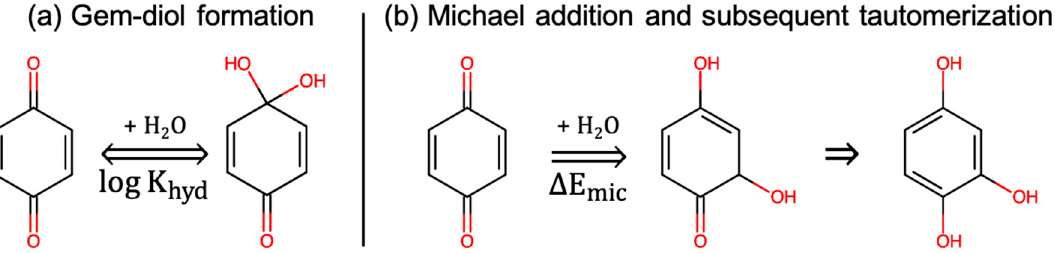
Figure 8. The mechanisms of chemical instability considered by Tabor et al. [39]. ( a ) Gem-diol formation, which is reversible but hampers kinetics. ( b ) Michael addition on the molecule in which a single vulnerable site of attack and subsequent tautomerization is shown.